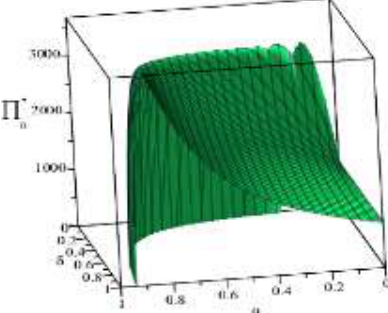
Figure 10. Effect of manufacturer behavior A on a supply chain network under performance conditions.